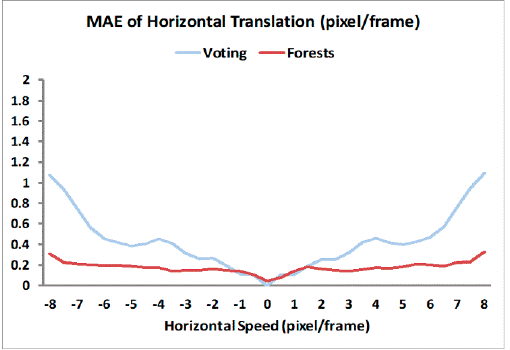
Figure 2. Mean Absolute Errors (MAE) of optical flow computation for 1D horizontal translation at different speeds from − 8 to 8 pixel/frame with a step of 0.5 pixel/frame.